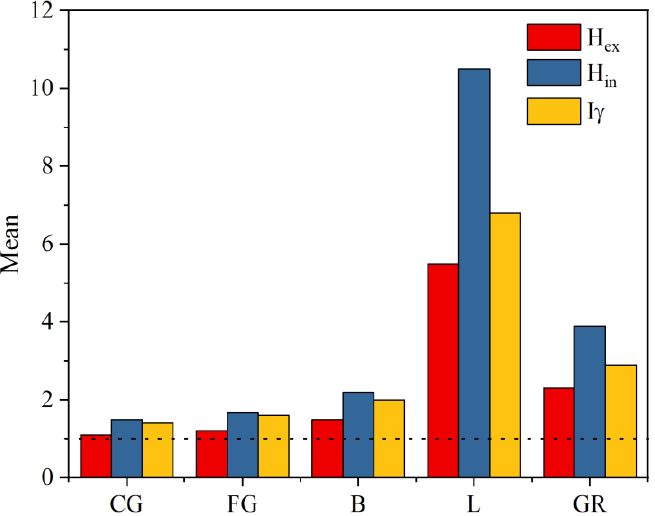
Figure 10. Mean values of the external (H ex ) and internal (H in ) hazard indices and representative gamma index (I γ ) of GR at the Sol Hamed area, Egypt.